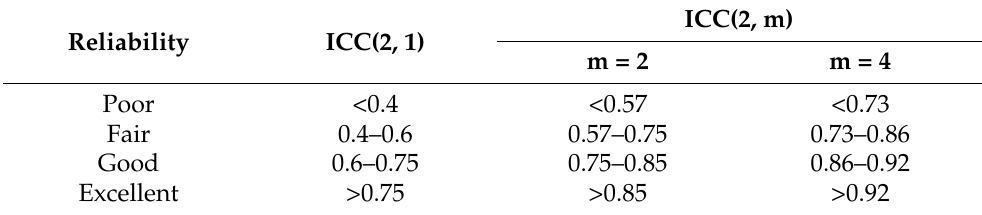
Table 3. Thresholds for interpretation of Intraclass Correlation Coefficient (ICC) between